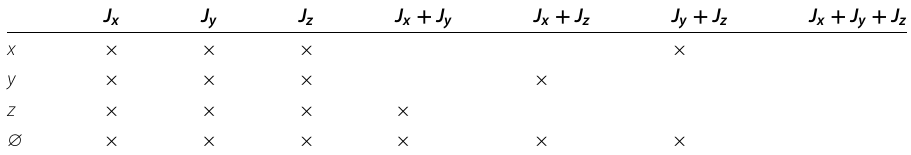
Table 1 Subsets of Heisenberg parameters H CD for which circuits are constant-depth. The rows denote the direction of the external field or a lack of a field. The columns denote the non-zero coupling parameters. Table entries marked with an × denote parameter sets that represent Hamiltonians for which our constant-depth circuits work J